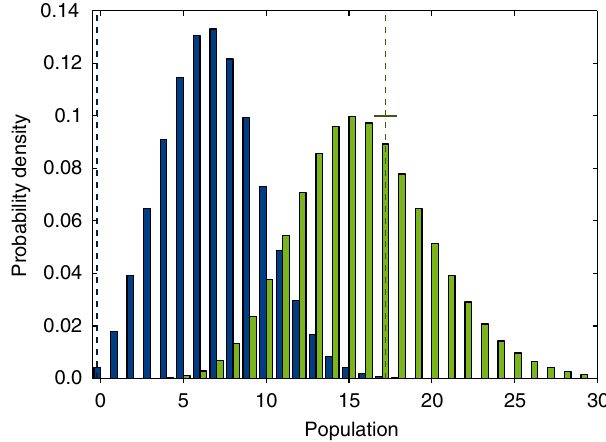
Figure 3 | Simulated number of exoplanets in and below the hot-super-Earth desert. Histograms of the number of exoplanets in (blue) and below the hot-super-Earth desert (in radius, green) using a Gaussian mixture model of the seismic subsample under the assumption of no gap. The two dashed lines show the observed number of planets in (dark blue) and below the desert (dark green); 0 ± 0.04 and 17 ± 0.7, respectively. The histograms are based on 5 million